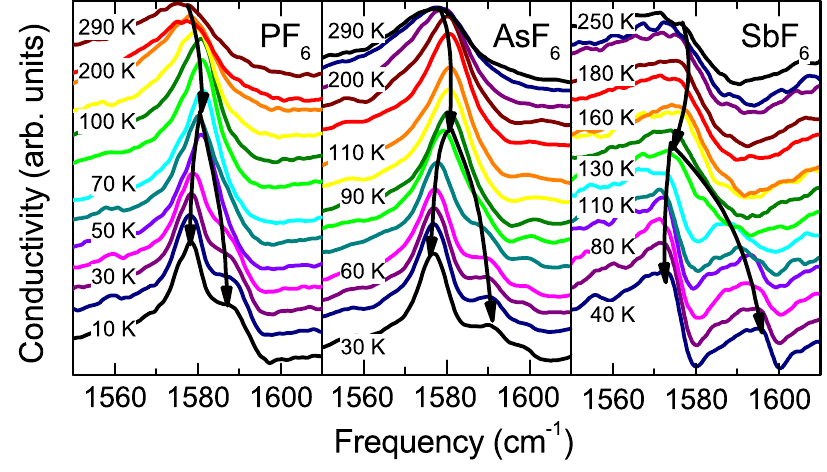
X with X = PF − = 67 K), AsF − Figure 10. The optical conductivity of (TMTTF) ( T 2 CO 6 6 = 102 K) and SbF − = 157 K) recorded along the c -direction for different ( T ( T CO CO 6 temperatures as indicated. The conductivity was shifted by a constant factor for better ( b ) mode splits in two components as shown by the two clarification. Below T , the ν CO 28 1 u black arrows. It is interesting to note that in the case of (TMTTF) SbF the modes have a 2 6 strong Fano